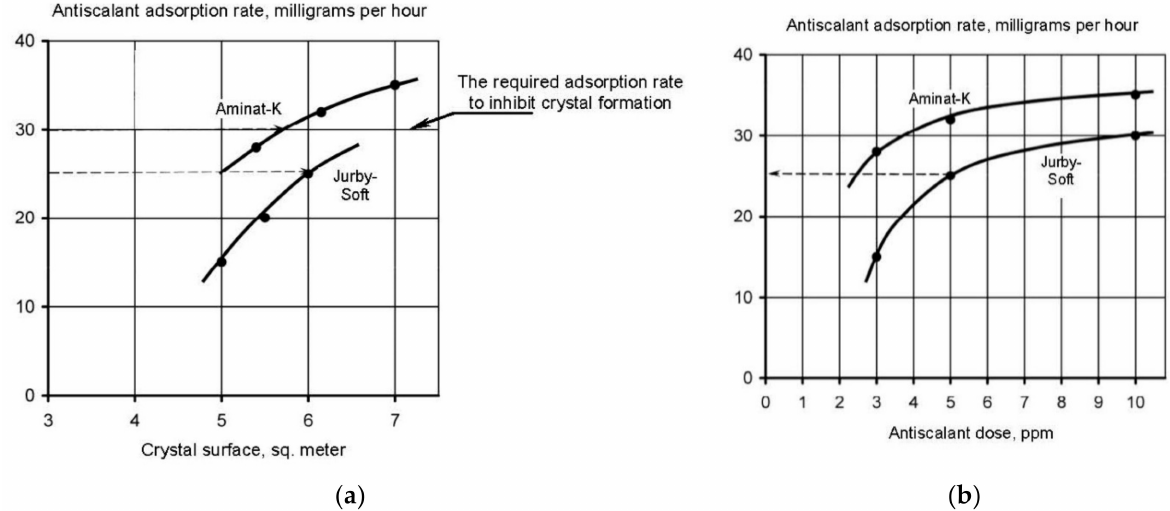
Figure 13. Results of Aminat-K and Jurbysoft adsorption properties evaluation: ( a ) dependence of adsorption rate on antiscalant dose; ( b ) dependence of adsorption rate on